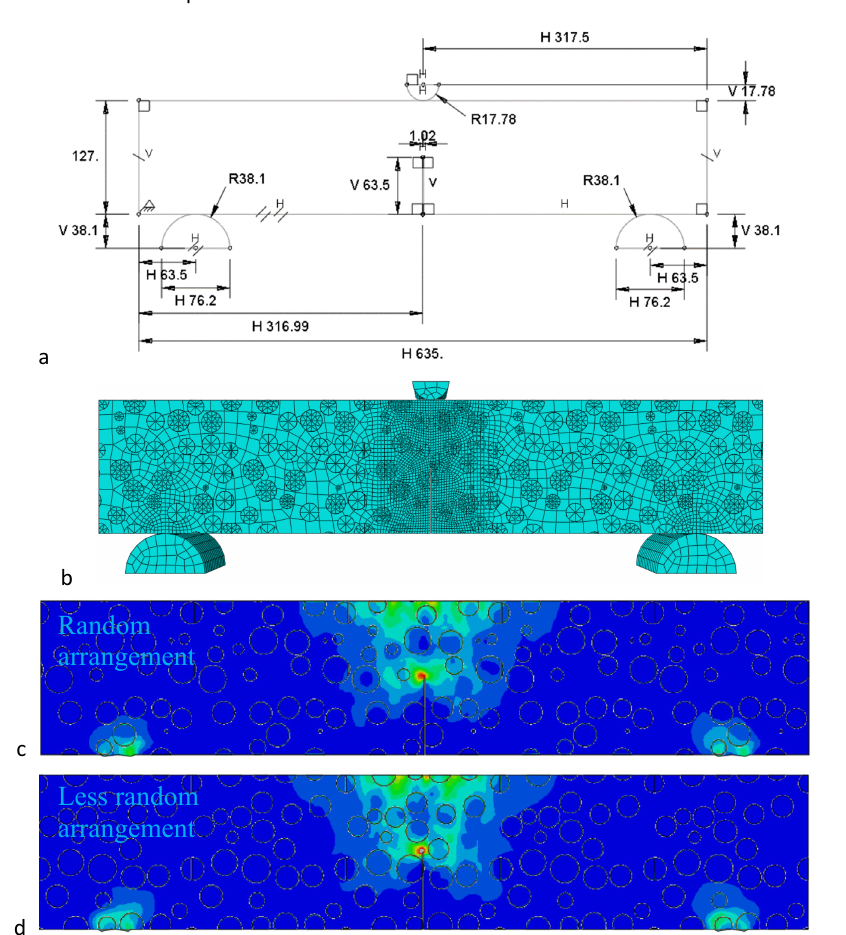
Figure 2. a) Dimensions (mm) of the numerical model and b) the mesh showing the embedded aggregate. Note that the combined hexahedron and tetrahedron mesh with ~171000 nodes is refined near the crack to resolve the stress field. A typical Von Misses stress field for the random (c) and less random (d) aggregate distribution is